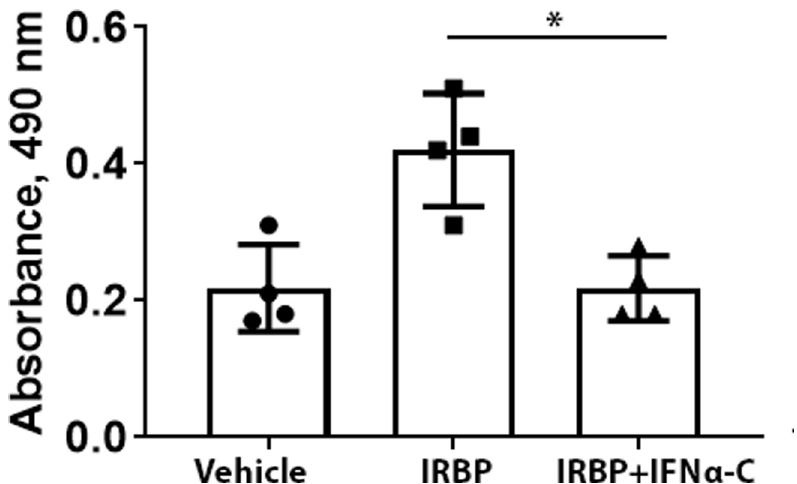
Fig 8. IFN α -C suppressed the IRBP-induced proliferation of splenocytes. Splenocytes were harvested from IRBP- immunized B10.RIII mice 3 weeks after immunization. Splenocytes (5x10 5 cells/well) in 96 well plates were grown in RPMI with 10% FBS. IFN α -C (3 μ M) was added for 4 hr followed by addition of IRBP (50 μ g/ml) and cells were grown for 72 hrs. Cell proliferation was measured as described in Material and Methods. The error bars indicate standard deviation. P =